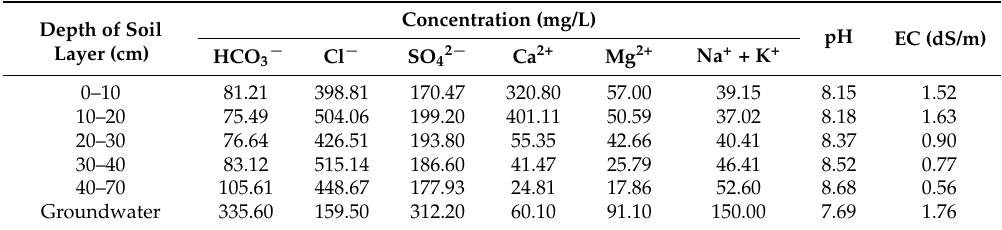
Table 2. Solution chemistry of soil pore water and